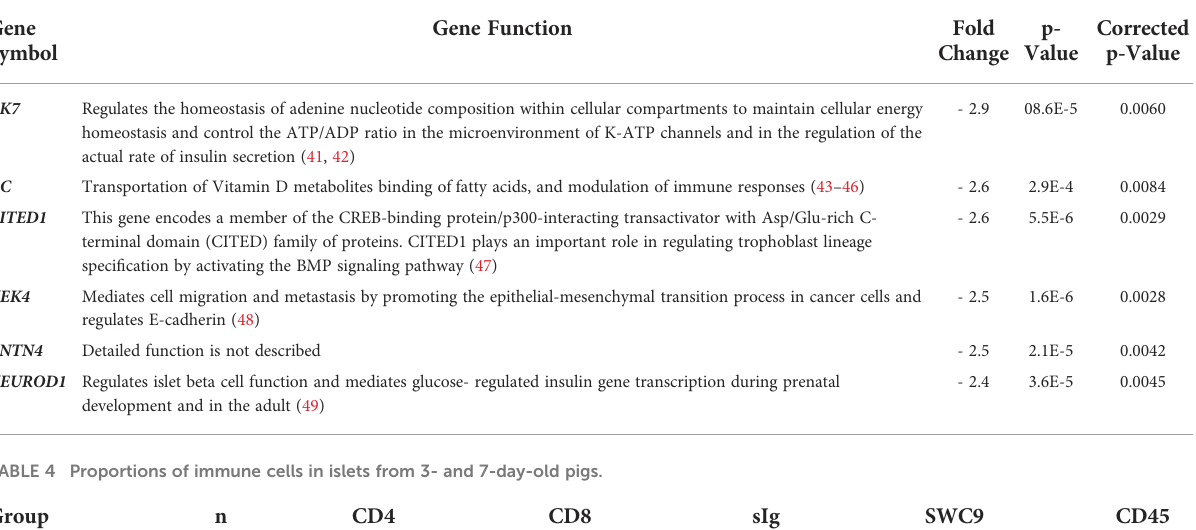
TABLE 3 Most down-regulated (-) genes in islets from 7-day-old pigs compared to islets from 3-day-old pigs. Gene Symbol